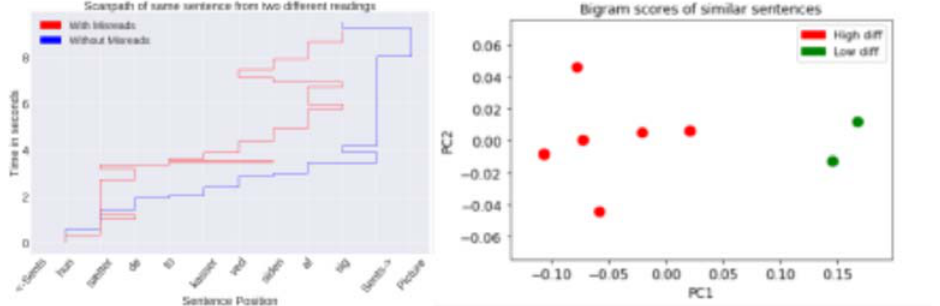
Figure 1. (a) Two scan path plots of the same sentence, one with at least one misread word (red) and without any misreads (blue). “<‐ Sents” means fixation on a previous sentence on the same page, “Sents ‐>” refers to looking at a sentence ahead on the same page. “Picture” means the reader looked at the image on the same page. (b) shows the similarity between different readings of similar sentences, meaning they have the same sentence length and similar word lengths. One point is one reading. The clusters are based on the surprisal (bigram) score of each read sentence. PC1 and PC2 are the principal